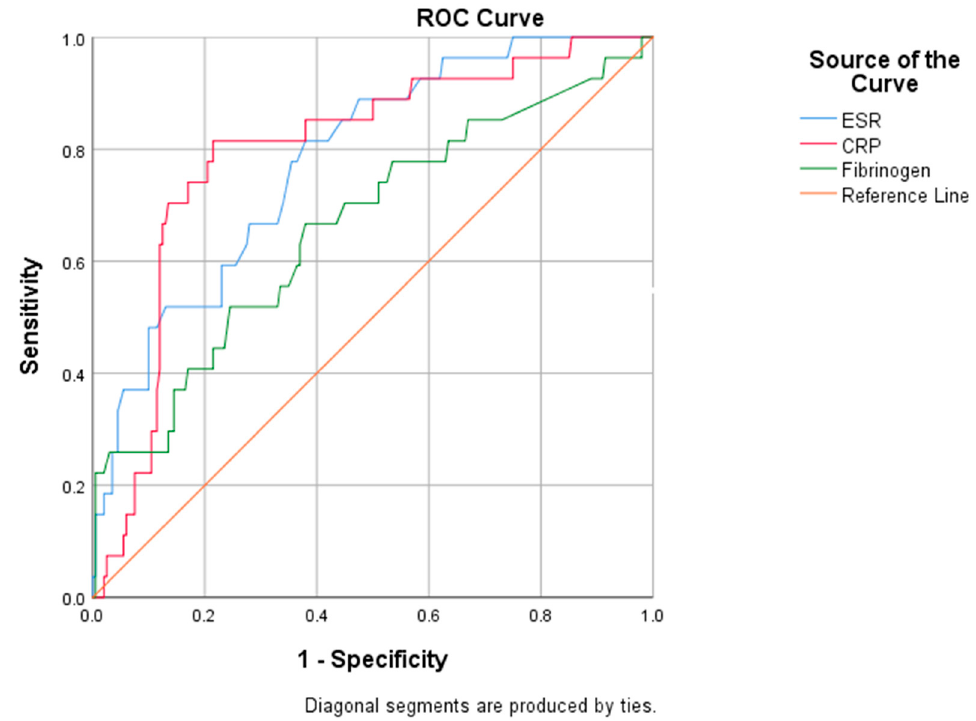
Figure 3. ROC analysis for specified biomarkers.